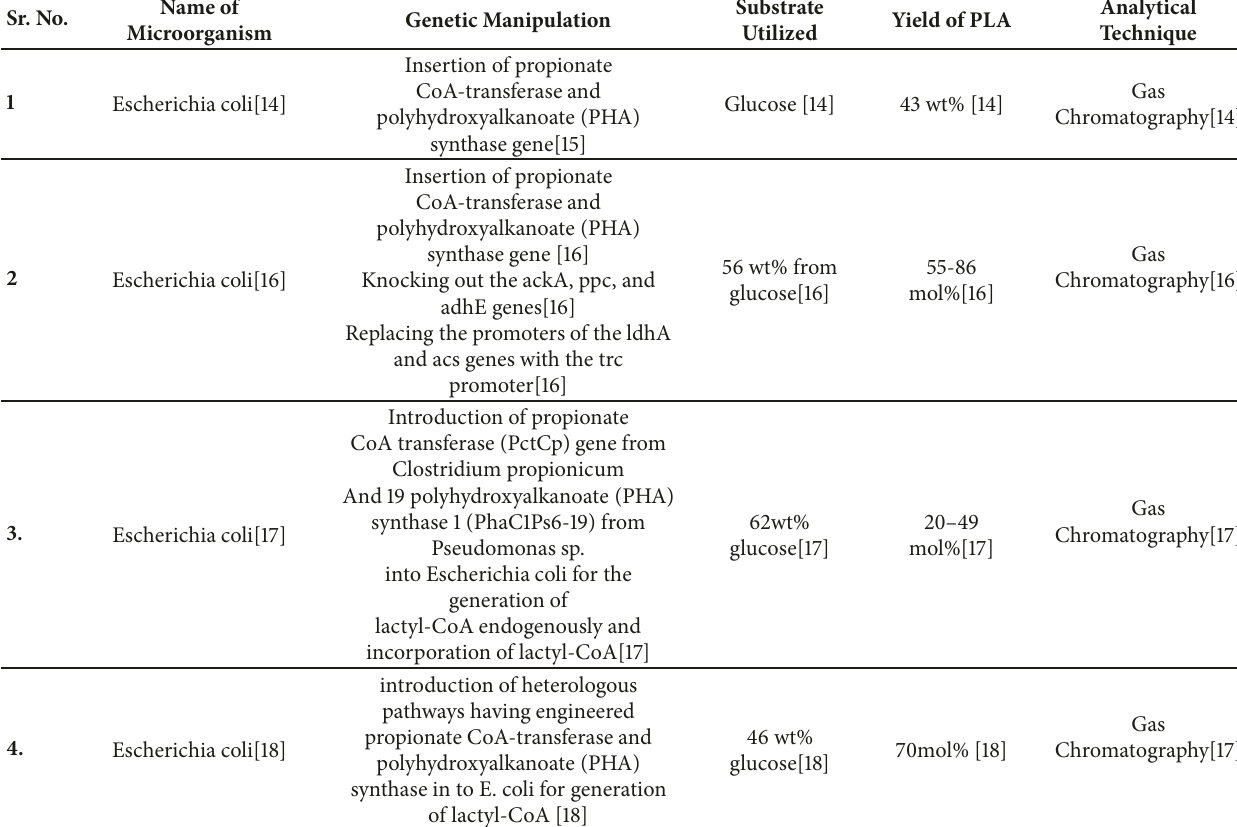
Table 2: Table summarizes genetically manipulated microorganisms used in PLA production. S r .